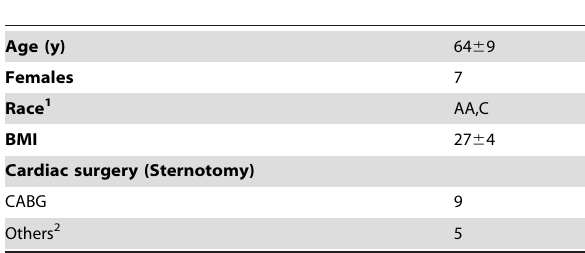
Table 1. Demographic characteristics of patients